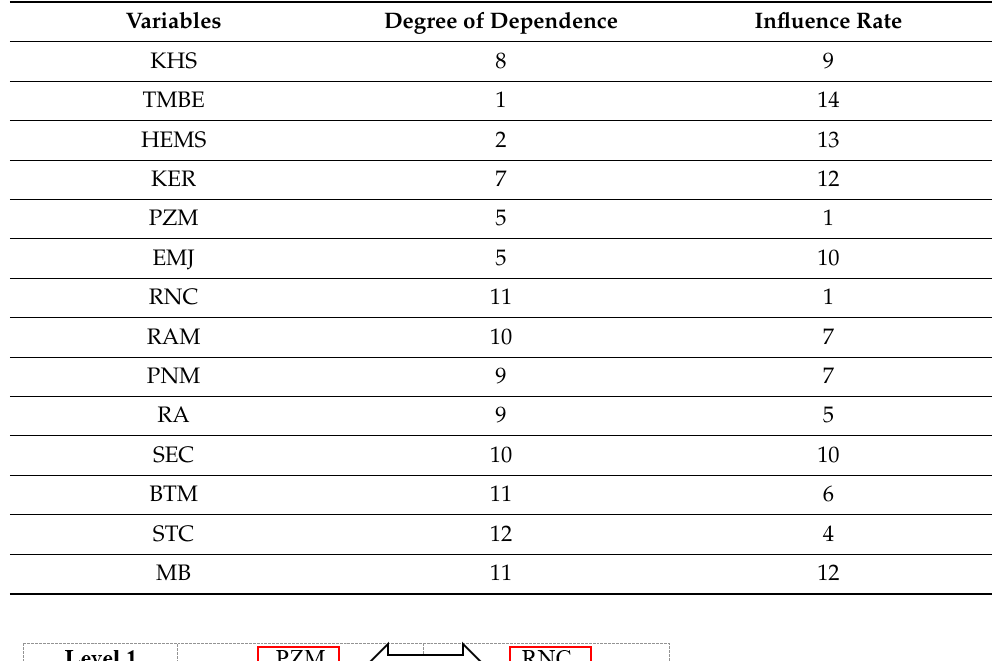
Table 9. Influence power and dependence of structural model variables (Ref: Authors).